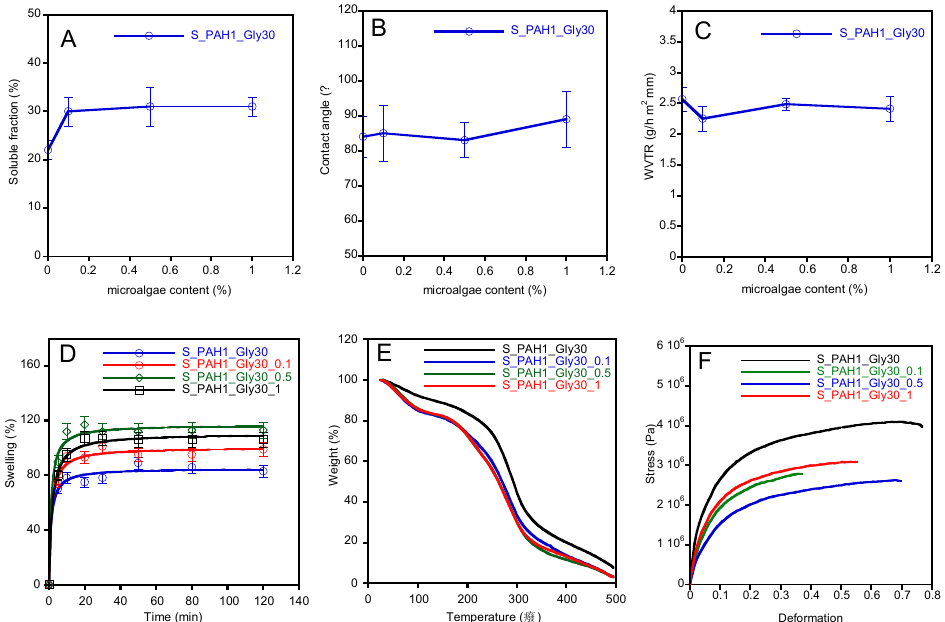
Figure 7. Physicochemical properties of S_PAH1_Gly30 films containing different microalgae amounts (0.1, 0.5 and 1% wt). Soluble fraction ( A ), Contact angle ( B ), water vapour transmission rate ( C ), swelling in water ( D ), thermogravimetric curve ( E ) and Stress-strain curve ( F ).